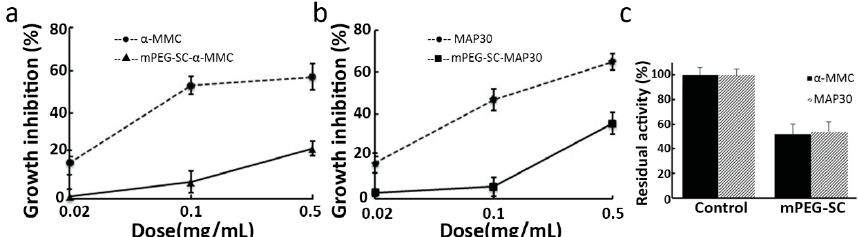
Figure 5. Inhibitory effects of α -MMC/MAP30 and mPEG-SC- α -MMC/MAP30 on human lung adenocarcinoma epithelial A549 cells. ( a ) A549 cells were treated with increasing concentrations of α -MMC and mPEG-SC- α -MMC for 72 h; ( b ) A549 cells were treated with increasing concentrations of MAP30 and mPEG-SC-MAP30 for 72 h; ( c ) Residual activity in comparison with α -MMC/MAP30 and mPEG-SC- α -MMC/MAP30 on A549 cells. Note: Each data point represented the average of three independent experiments performed in quadruplicate. Error bars showed standard deviations ( n = 3). One-hundred percent of residual activity was defined as the control group to which RIPs or m-PEG-SC-RIPs were not added. p < 0.05 compared with control